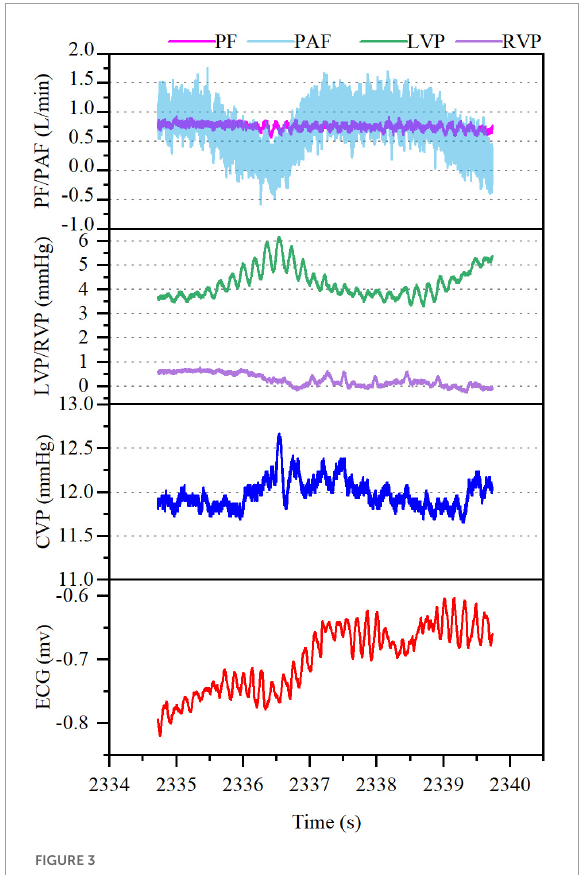
FIGURE3 Ventricular fibrillation (VF) with atrial fibrillation after CF-LVAD implantation (Model B). PF, pump flow; PAF, pulmonary artery flow; LVP, left ventricular pressure; RVP, right ventricular